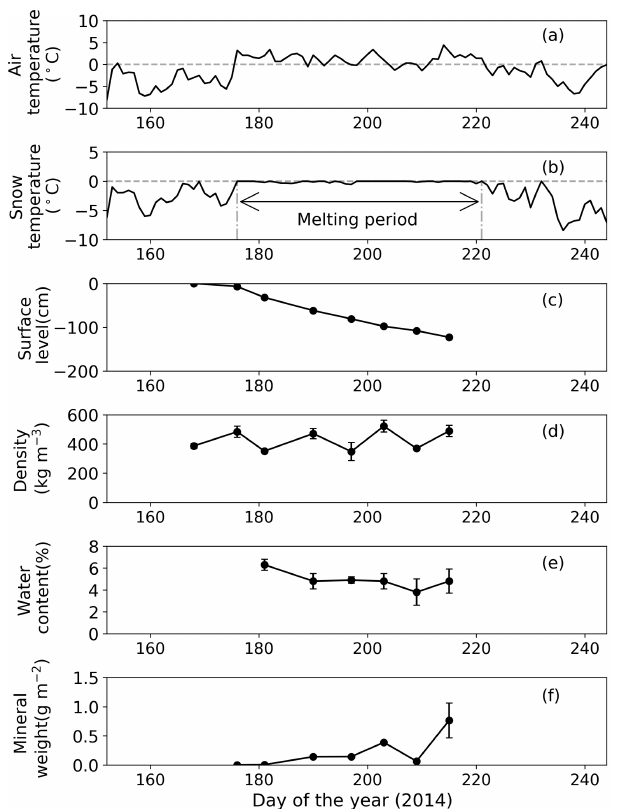
Figure 4. Meteorological and physical conditions on surface snow at Site B from 1 June to 1 September 2014. (a) Mean daily air tem- perature, (b) mean daily snow surface temperature calculated from observed downward and upward long-wave radiant fluxes, (c) rela- tive snow surface level at the site (0cm on day 168), (d) snow den- sity, (e) volumetric liquid-water content of snow, (f) abundance of mineral particles. Melt period in (b) is defined as the period from the first day to the last day when the daily mean snow surface tempera- ture was 0 ◦ C from 1 June to 1 September 2014. Standard deviation shown by error bars.